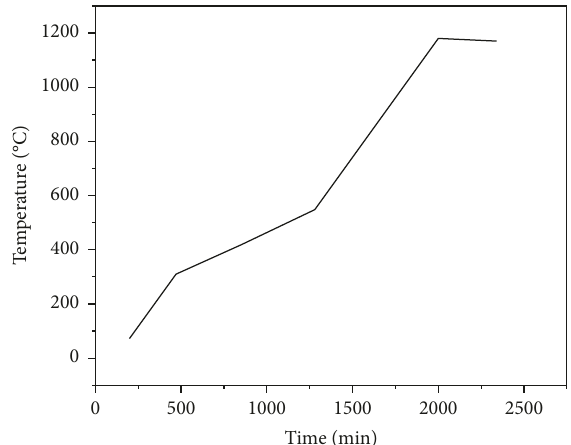
Figure 4: Sintering system of core